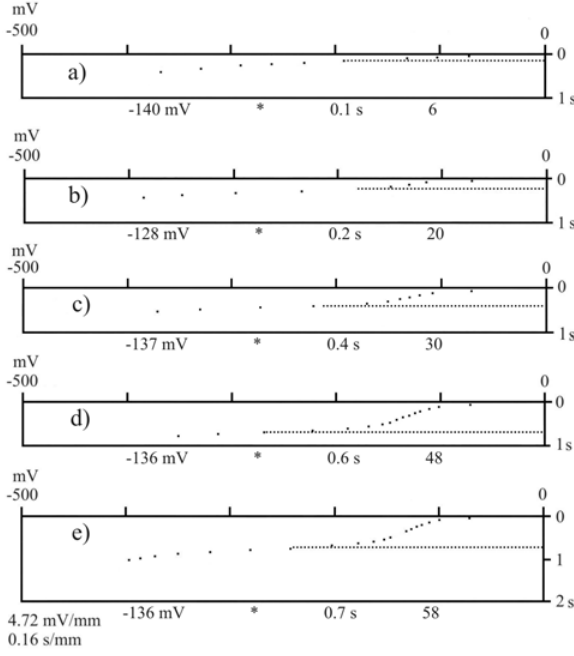
Figure 6. Chronopotentiogram of different concentration of ribof- lavin: (a) 10, (b) 30, (c) 40, (d) 60, and (e) 70 mg/dm 3 in 0.025 = 0.023 V, i = –5.3 mol/L HCl. E Initial